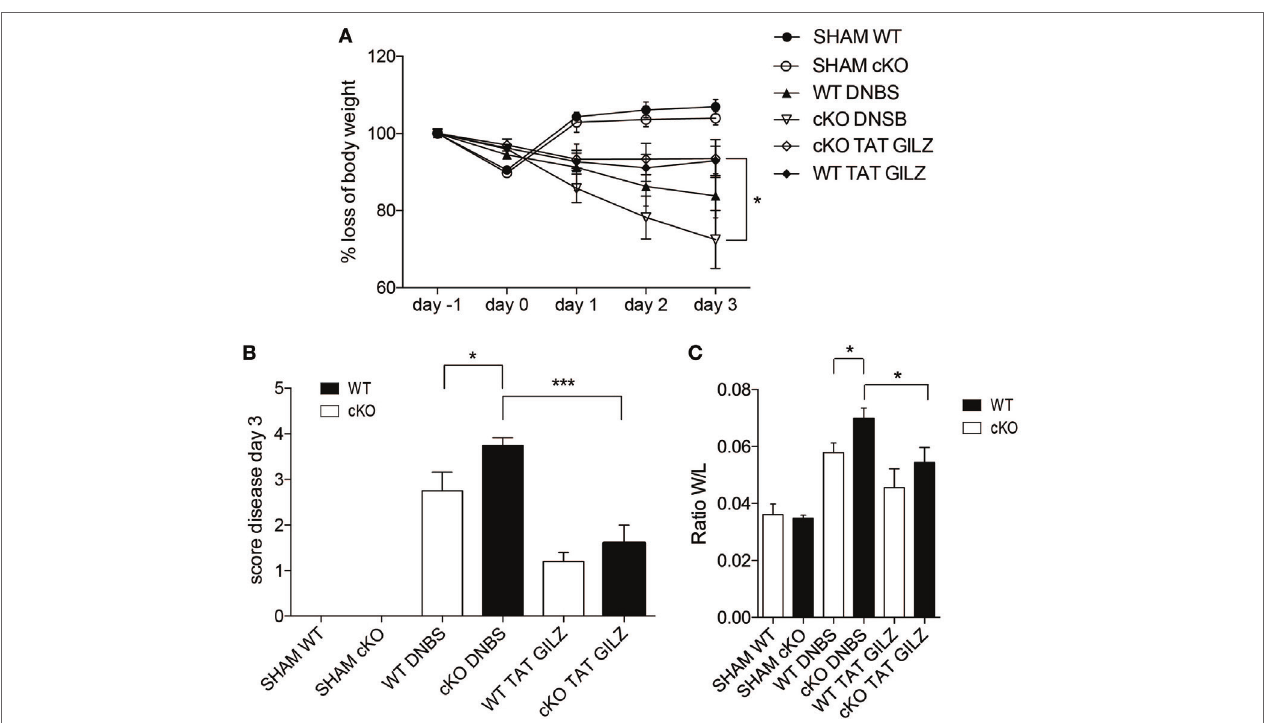
FigUre 7 | The TAT–glucocorticoid-induced leucine zipper (GILZ) fusion protein reverses the symptoms of dinitrobenzene sulfonic acid (DNBS)-induced colitis. (a) Loss of body weight in wild-type (WT) and gilz B cKO mice treated intrarectally with vehicle (Sham) or DNBS, with and without administration of TAT–GILZ fusion protein (daily i.p. administration of 0.5 mg/kg, starting from day 0). (B) Daily measurement of total disease score in WT and gilz B cKO mice during DNBS-induced colitis, treated with or without TAT–GILZ fusion protein. (c) Colon weight/length ratio of WT and gilz B cKO mice intrarectally administered with vehicle (Sham) or DNBS, treated with and without TAT–GILZ fusion protein. Data are from two independent experiments ( n = 6, 7). N.S., not significant, statistical analysis was performed using the unpaired Student’s t -test (* p < 0.05, ** p <